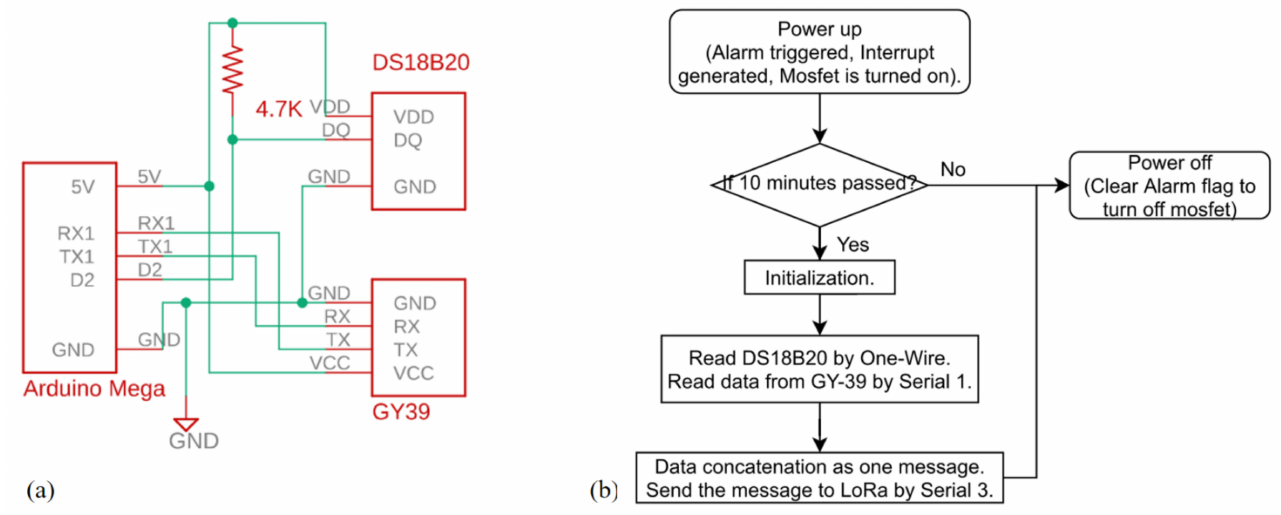
Figure 4. ( a ) A partial schematic and ( b ) the program flowchart for the type B